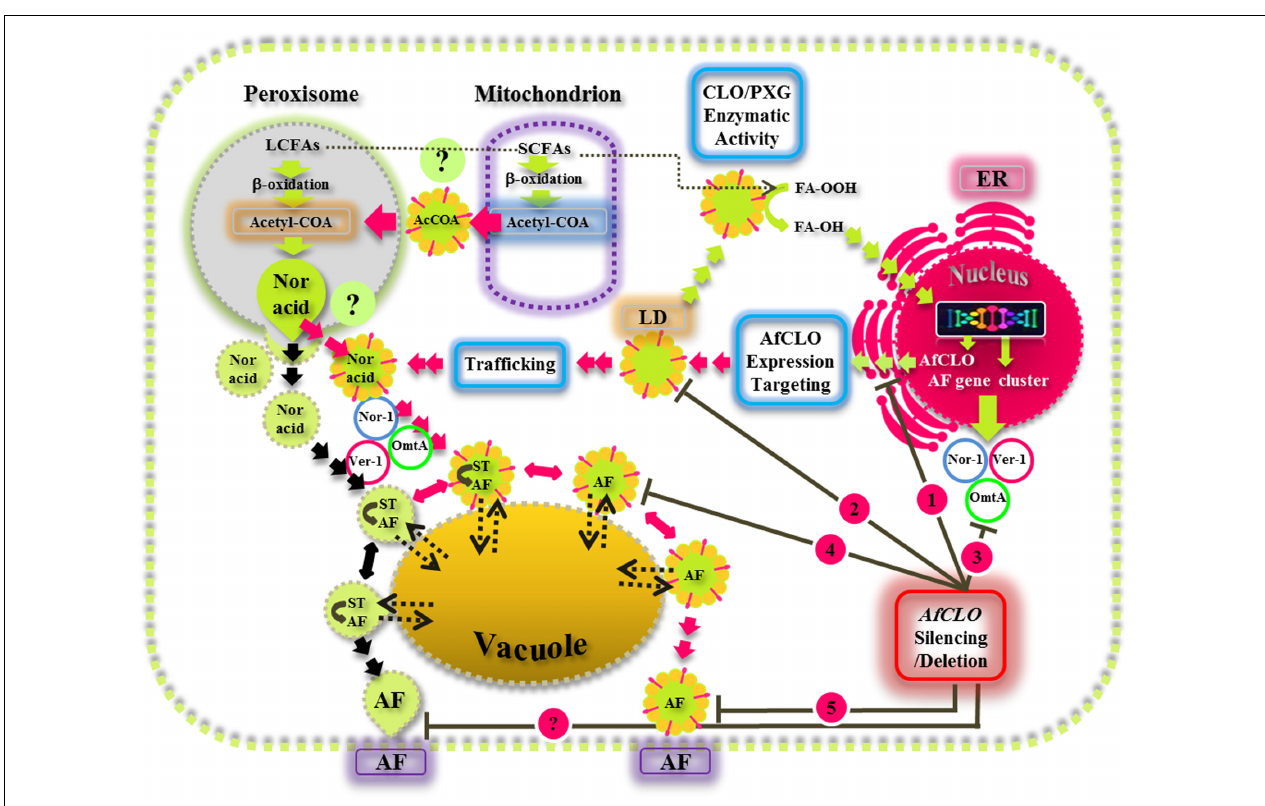
FIGURE 9 | A model for the biosynthesis, intracellular trafficking, and secretion of aflatoxins via a concerted mechanism involving peroxisomes, lipid droplets (LDs), and endomembrane components. In this scheme, the caleosin/peroxygenase (CLO/PXG) enzyme, located on LDs, is a component of oxylipin metabolism that converts fatty acyl peroxides (FA-OOH) to fatty acyl hydroxides (FA-OH). This is part of the oxidative signaling cascade that regulates the expression of several components of the aflatoxin (AF) gene cluster located in the nucleus. AF biosynthesis begins in peroxisomes with the β -oxidation of long chain fatty acids (LCFAs) to acetyl-CoA which is then converted to the polyketide, Norsolorinic acid (Nor Acid), via polyketide synthase. Vesicles and LDs, loaded with Nor Acid, then bud off from peroxisomes (and possibly also from mitochondria) and are trafficked via CVT (cytoplasmic vacuole targeting) vesicles that contain middle and late aflatoxin enzymes such as Nor-1, Ver-1, and Omt-A. The aflatoxin-loaded vesicles fuse with secretory vesicles to form aflatoxisomes that can either be recycled via the vacuole or secreted from the cell (black arrows). In the alternative pathway that has been elucidated in this study, LDs can also become loaded with AF and can then either be recycled via the vacuole or secreted from the cell (red arrows). Silencing of the AfCLO gene results in the downregulation of several key AF gene cluster components, as well as much reduced LD accumulation and an almost total cessation of AF biosynthesis and secretion.